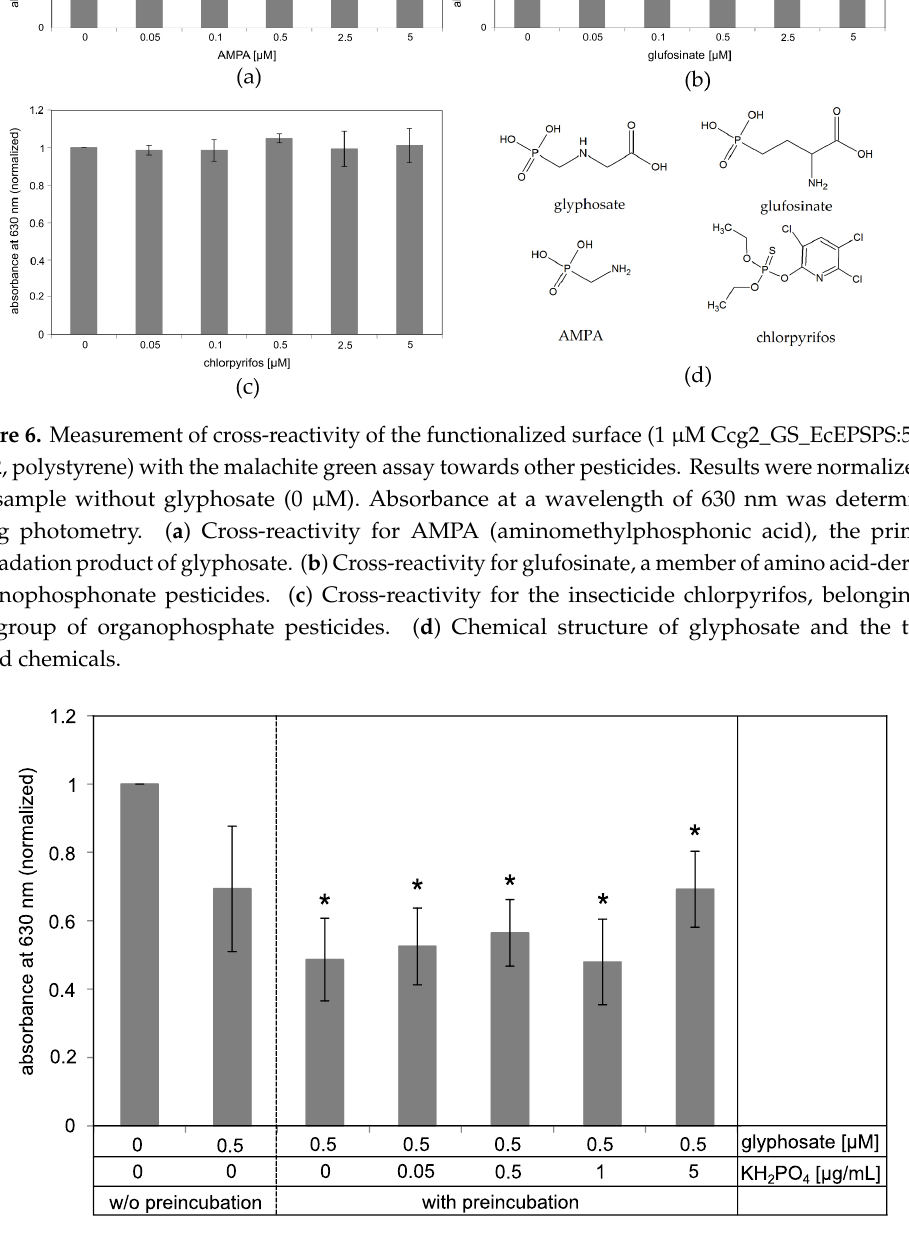
Figure 7. Malachite green assay with preincubation of the surface for 15 min with a solution containing 0.5 µ M glyphosate and di ff erent phosphate concentrations. After removal of preincubation solution, the assay was performed as described. Samples with 0 and 0.5 µ M glyphosate without preincubation were used as positive controls. Results were normalized to the sample without glyphosate (0 µ M). Absorbance at a wavelength of 630 nm was determined using photometry. * p -value ≤ 0.05 compared to sample 0 µ M glyphosate w / o